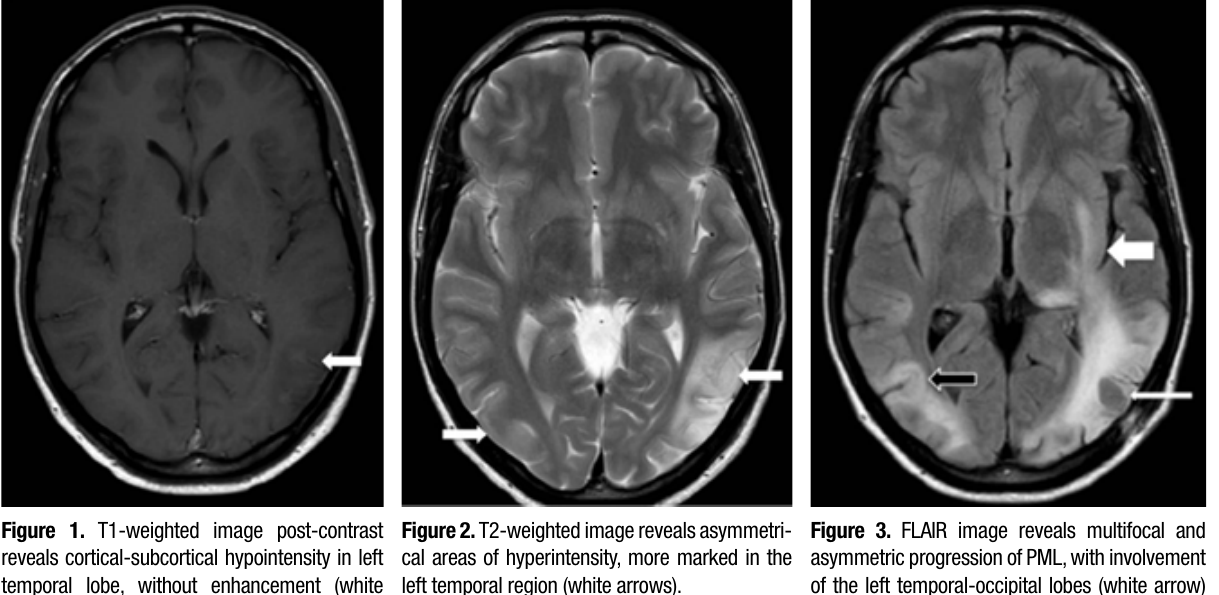
Figure 1. T1-weighted image post-contrast reveals cortical-subcortical hypointensity in left temporal lobe, without enhancement (white arrow).